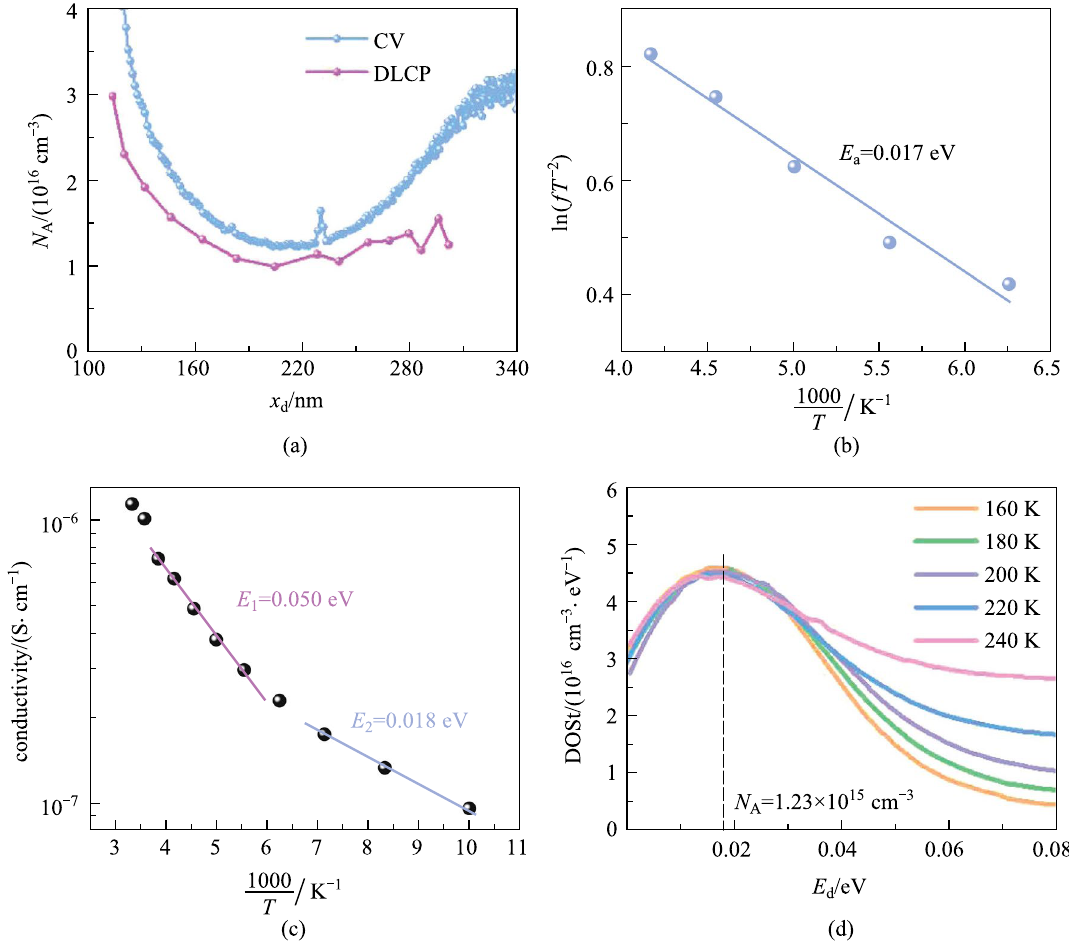
a Relationship between N A and x d measured by C–V and DLCP. b Arrhenius plot. c Temperature dependent dark-state conductivity. d Defect